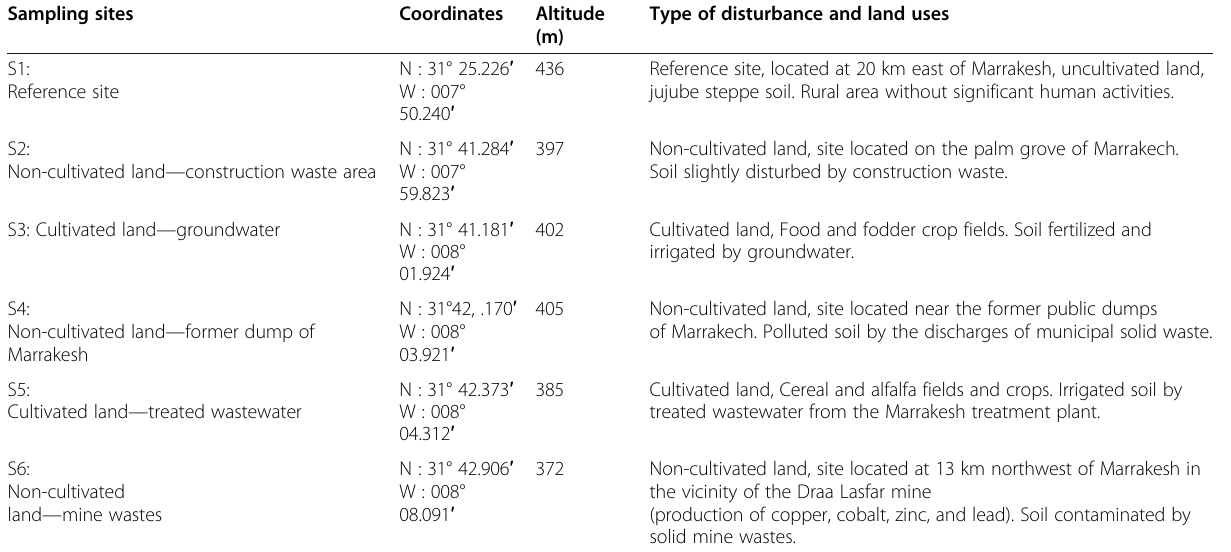
Table 1 Description of sampling sites Sampling sites Coordinates Altitude